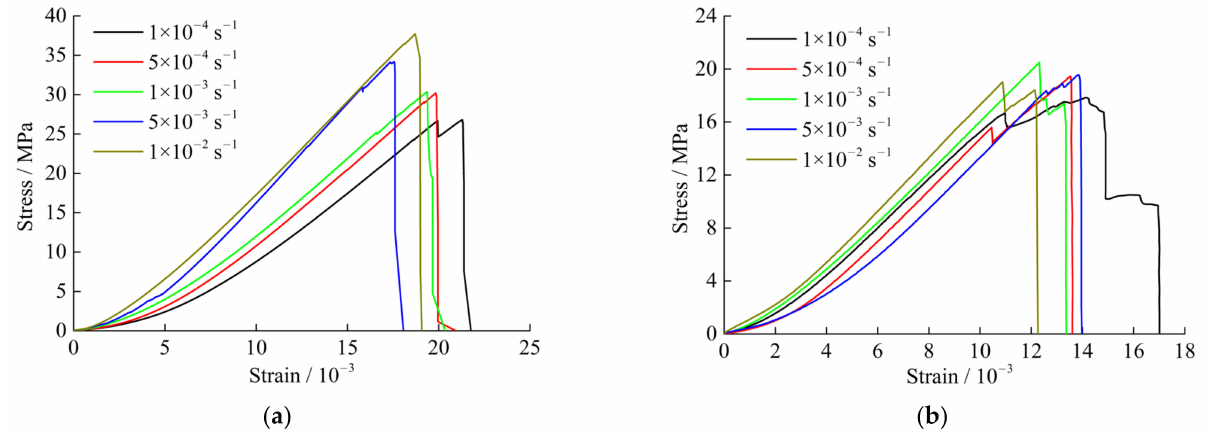
Figure 9. Stress-strain curves under different strain rates: ( a ) Horizontal bedding; and ( b ) Vertical